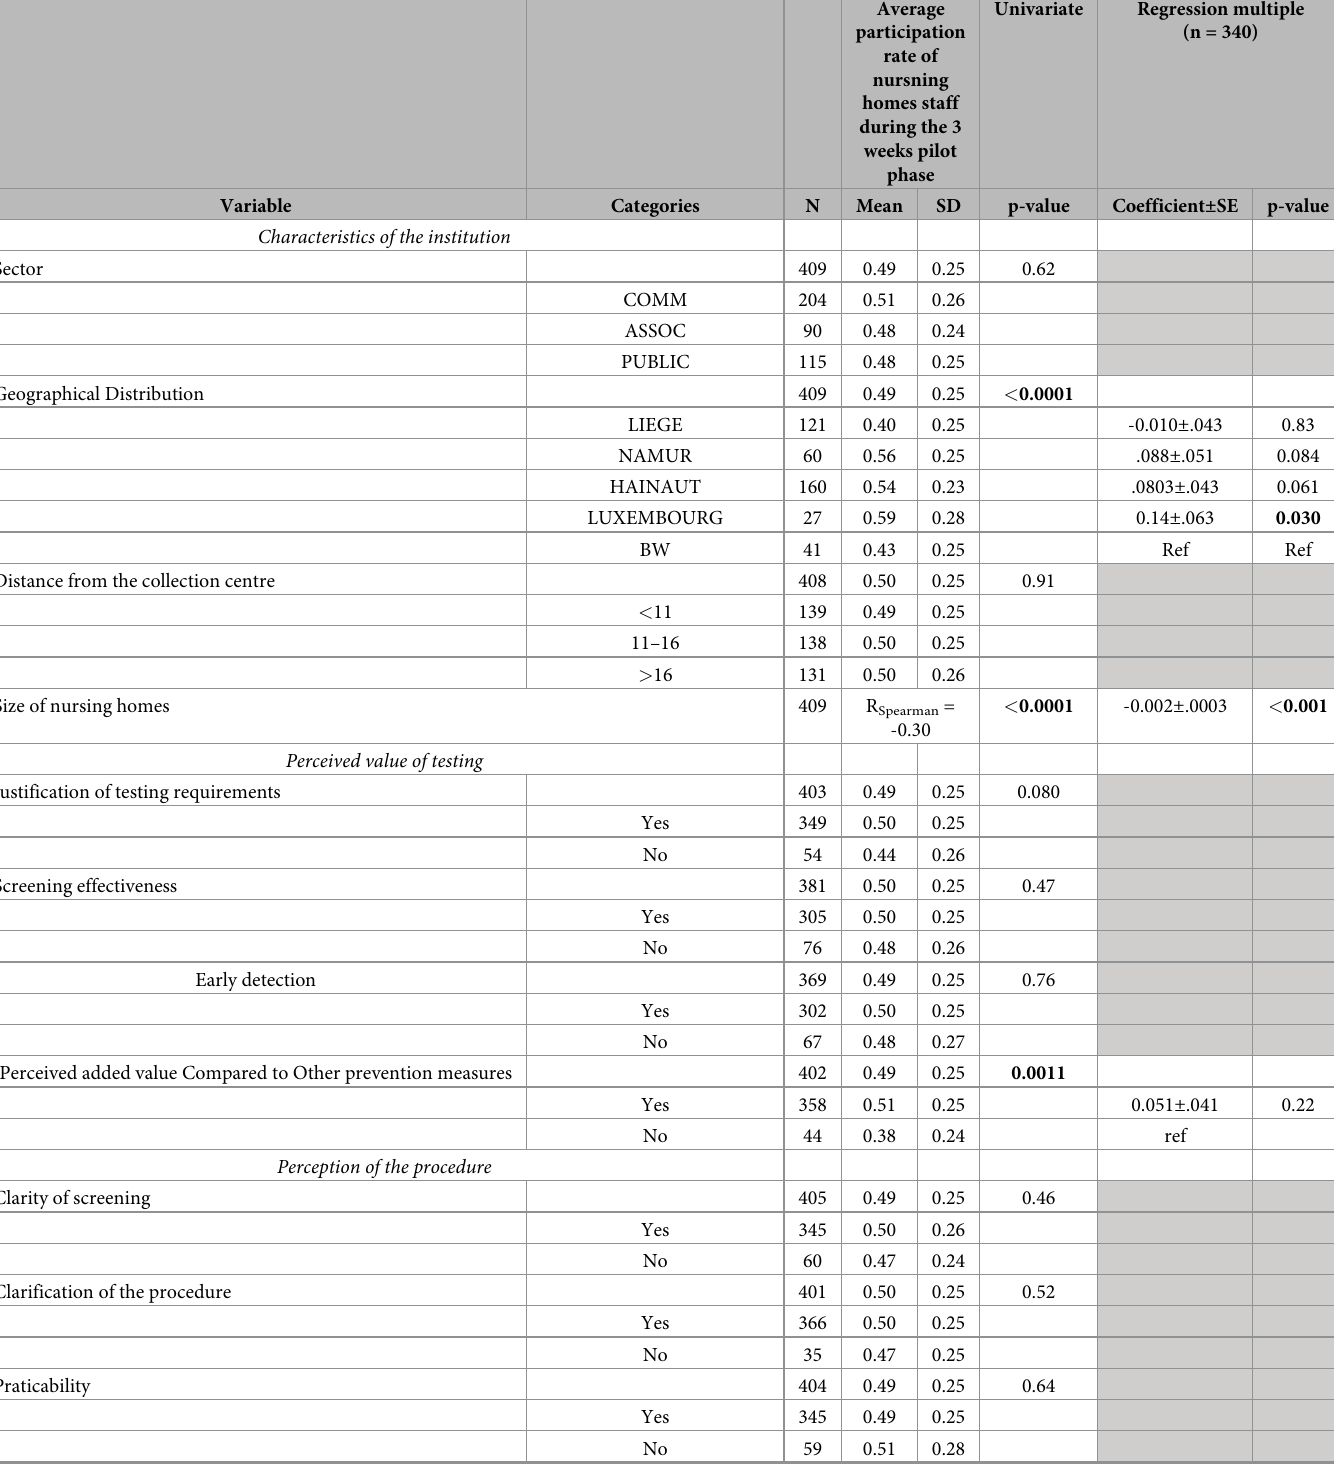
Table 2. Factors determining the level of staff engagement to a system of systematic screening of saliva testing of staff to control the spread of Covid-19 by Walloon nursing homes (n = 409, December 2020) (R 2 =